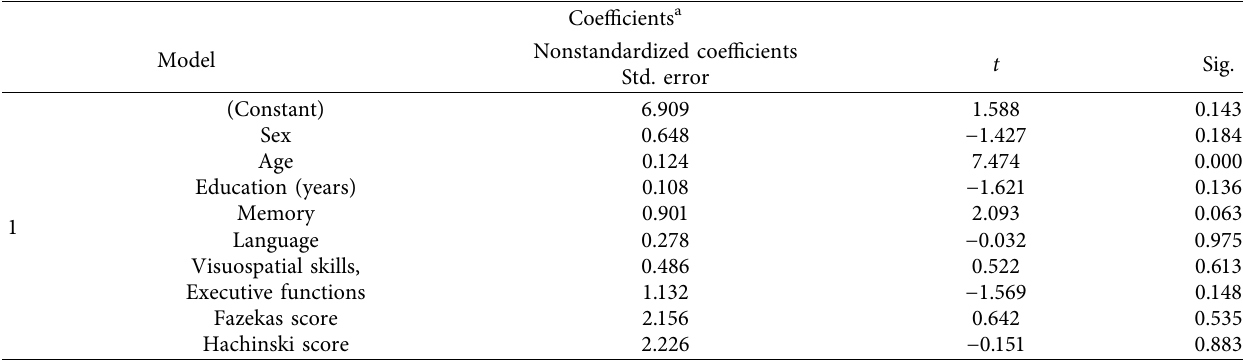
Figure 7: Changes in risk of AD, VD, and MXD development with Fazekas and Hachinski scores. Table 2: Coefficient values for